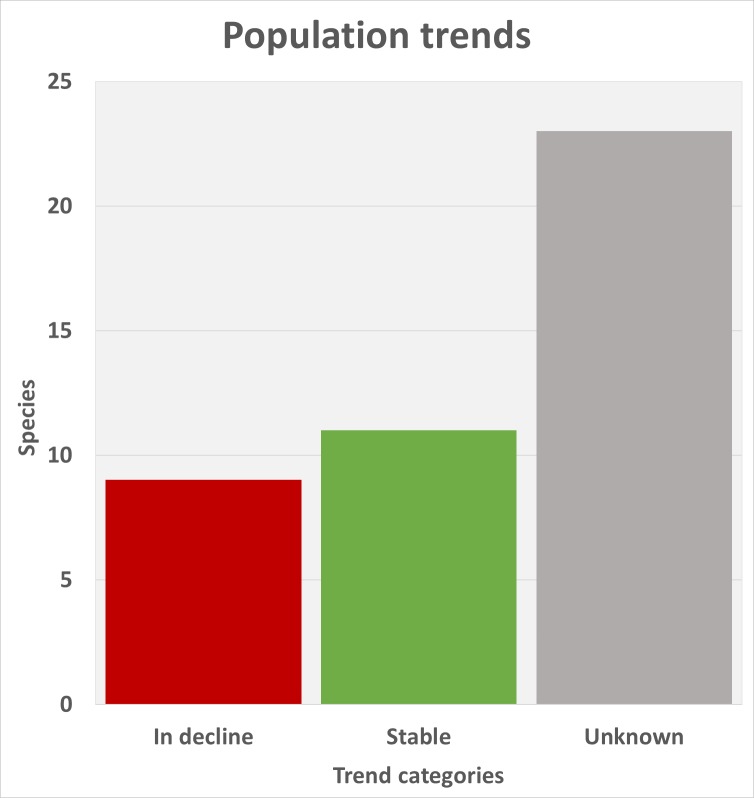
Population trends amongt all species.